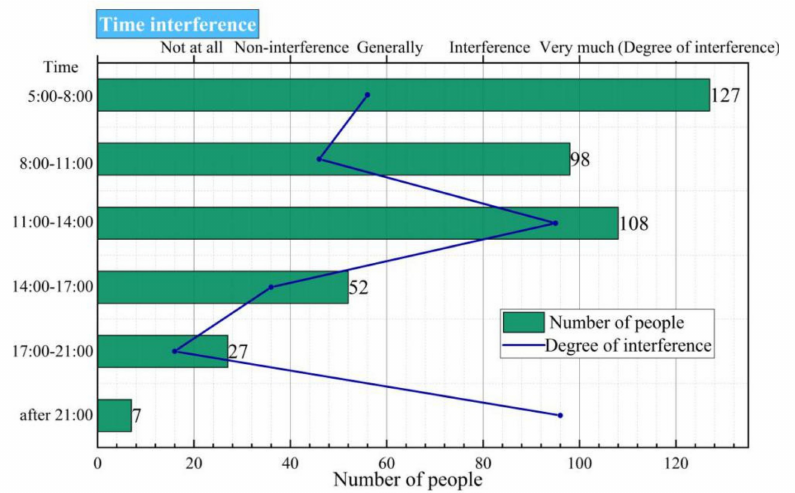
Figure 4. Activity time (without sound